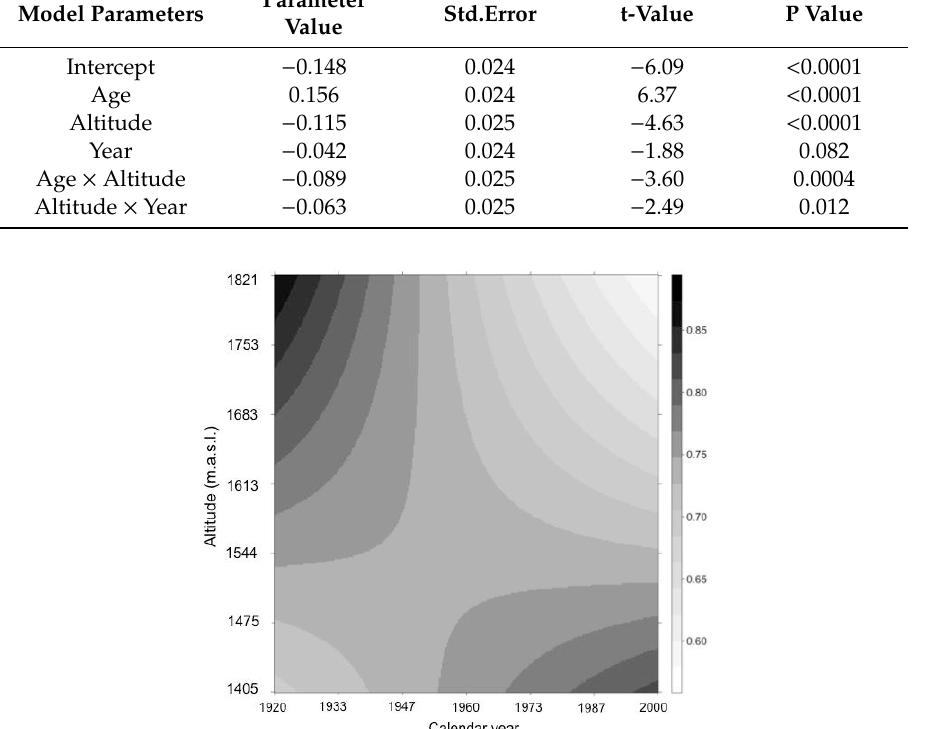
Figure 3. Contour plots showing tree growth responses (cm 3 ) to pair-wise interactions over the years and the altitude.